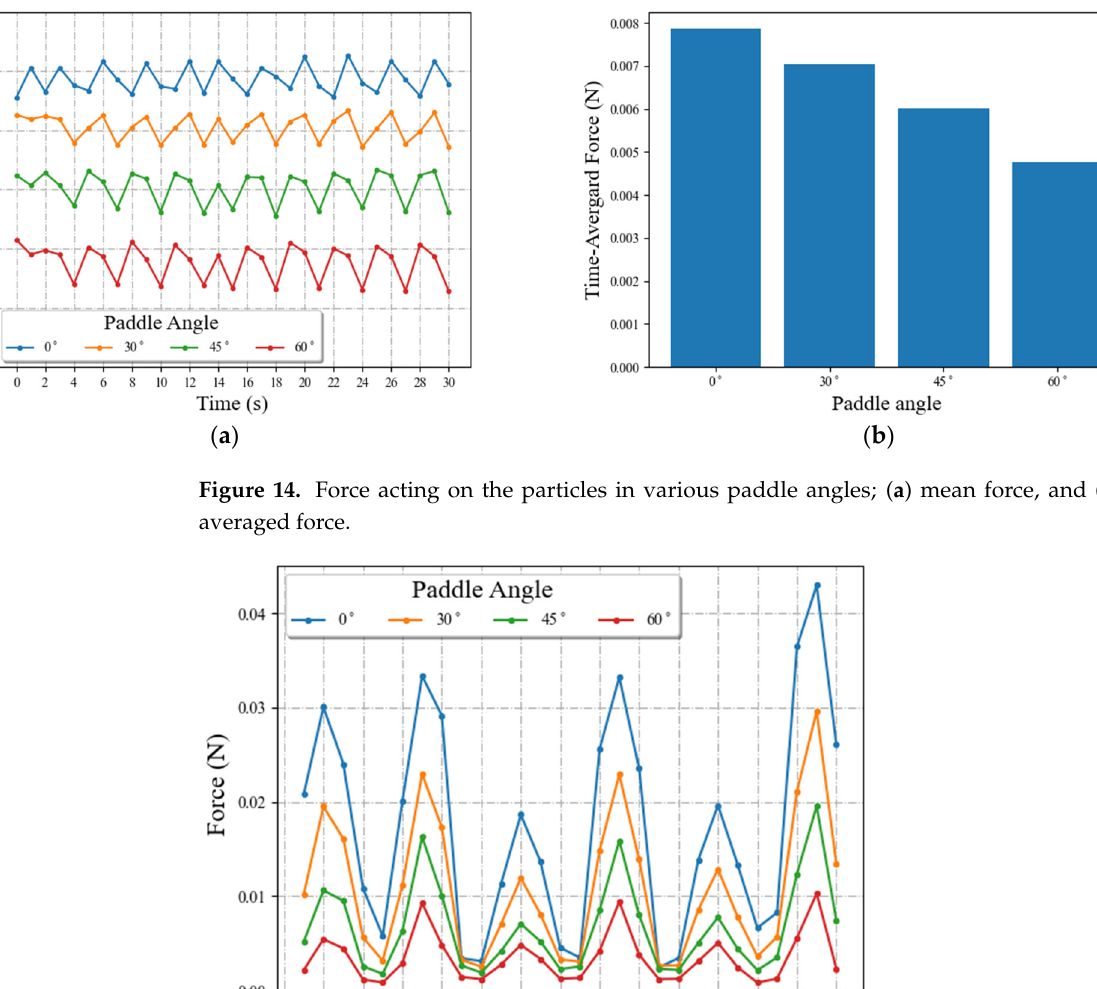
( d ) Figure 16. Contour of time ‐ averaged forces acting on particles for various paddle angle of ( a ) 0°, ( b ) 30°, ( c ) 45°, and ( d ) 60°. The effects of paddle angle are also examined on the system’s power consumption. Figure 17 depicts the power consumption of the mixer for various paddle angles. Due to the impellers’ rotation, and changes in the torque acting on impellers, the power